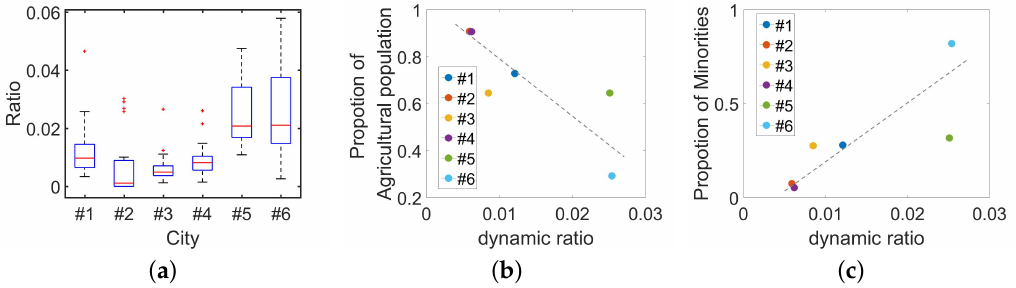
Figure 14. ( a ) Population flow dynamic index in 6 cities. ( b ) Relation between population composition (the proportion of agricultural population) and population flow dynamic index. ( c ) Relation between population composition (the proportion of minorities) and population flow dynamic